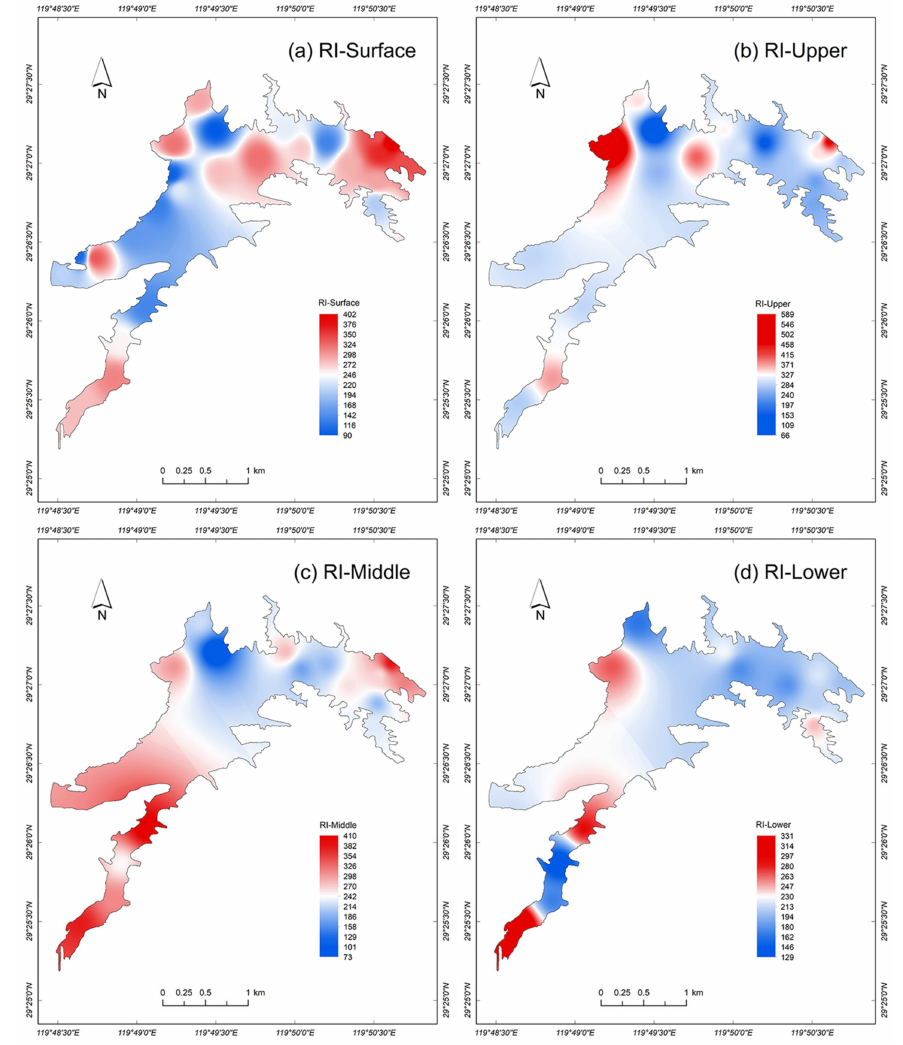
Figure 4. Potential ecological risk of sediments from heavy metals of the Tongjiqiao Reservoir: Distribution of the risk index (RI) of sediments in the ( a ) surface, ( b ) upper, ( c ) middle, and ( d ) lower sediment